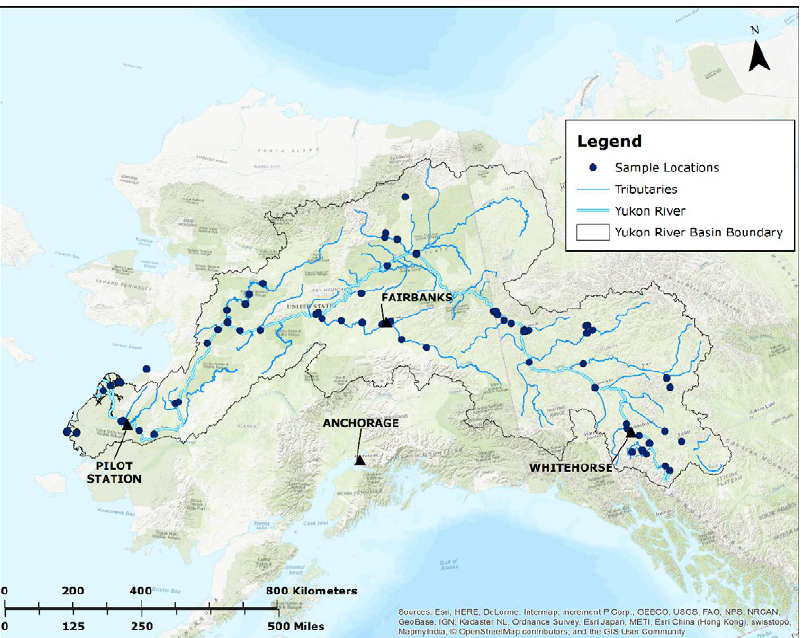
Figure 1: The Yukon River Basin in Alaska and Canada showing all ION sample locations from 2006–2014. Trian- gles identify major cities in the basin as well as the village and sampling location of Pilot Station, from which the water-quality data used in this study were